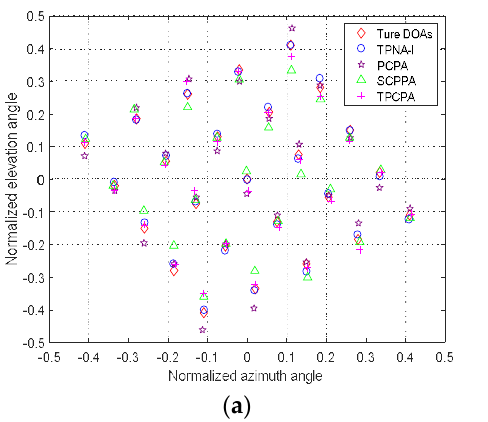
11 of 16 Figure 4. Continuous DOFs comparison for five kinds of physical array configurations. 4.2. 2-D DOA Estimation Results In the second experiment, we compared the 2-D DOA estimation results of five kinds of different array configurations and the respective 2-D DOA estimation method. The number of sensors of the five different array configurations were set as 18, i.e., (cid:1840) (cid:2869) = 8 , (cid:1840) (cid:2870) = 5 for TPNAs-I and TPNAs-II, according to Section 3.1, (cid:1839) = 5 , (cid:1840) = 8 for PCPA, (cid:1839) = 3 , (cid:1840) = 4 for SCPPA and (cid:1839) = 4 , (cid:1840) = 5 for TPCPA. Thus, we know that their continuous DOFs are respectively equal to 65, 79, 52, 47 and 47. This shows that, under the situation of the same number of sensors, the two proposed kinds of TPNAs and 2-D DOA estimation method can detect more sources than PCPA, SCPPA and TPCPA, as well as the corresponding 2-D DOA estimation method. Assuming 25